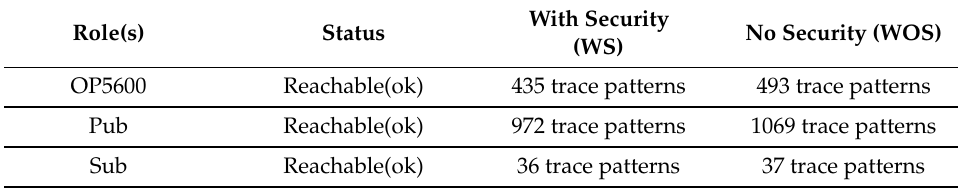
Table 6. Role characterization for correctness and completeness.